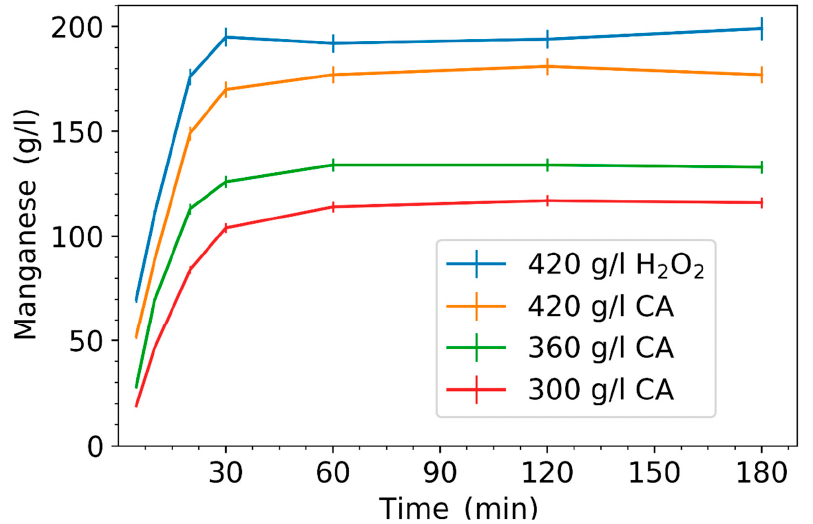
Figure 7. Effect of S/L on manganese concentration as a function of time at 60 °C.